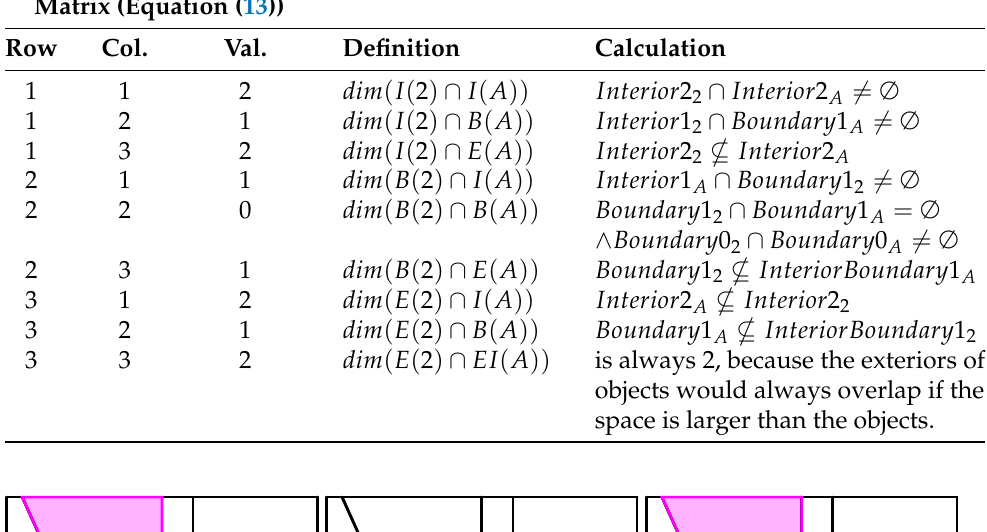
Table 4. DE-9IM matrix of the features 2 and A of Figure 10 (Equation (13)).